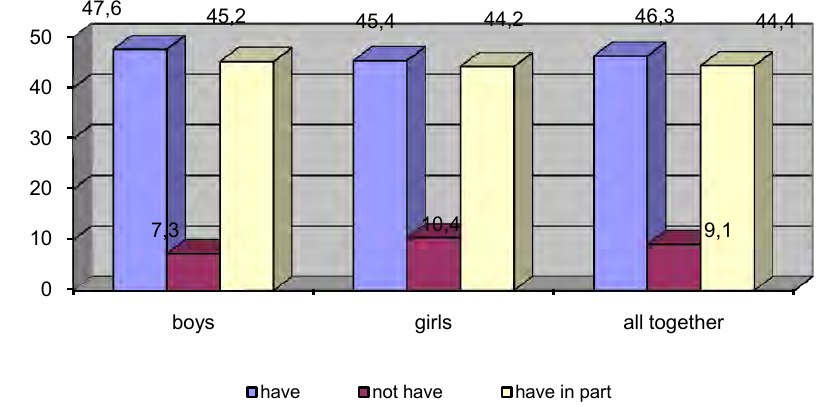
Fig. 1. Schoolchildren’s awareness of the subject of the Olympic Movement